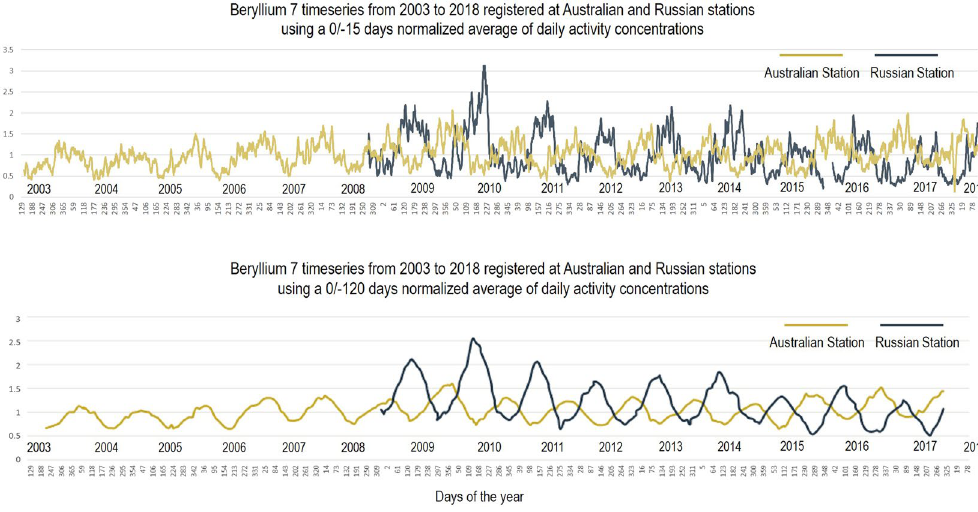
Figure 2. Multi-year time series (2003–2018) from Australian (orange line) and Russian Stations (blue line) based on normalized daily activity concentration of beryllium-7 averaged over 0/ − 15 days and 0/ − 120 days. Each data point represents the average of the past 15 days (top chart) and of the past 4 months (lower